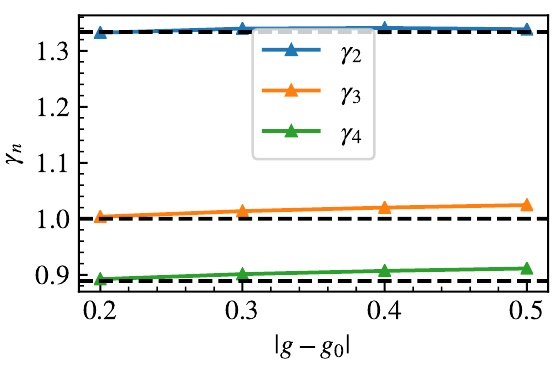
= 0.7 to g = 0.5,0.4,0.3,0.2. The dashed quenching from g n 0